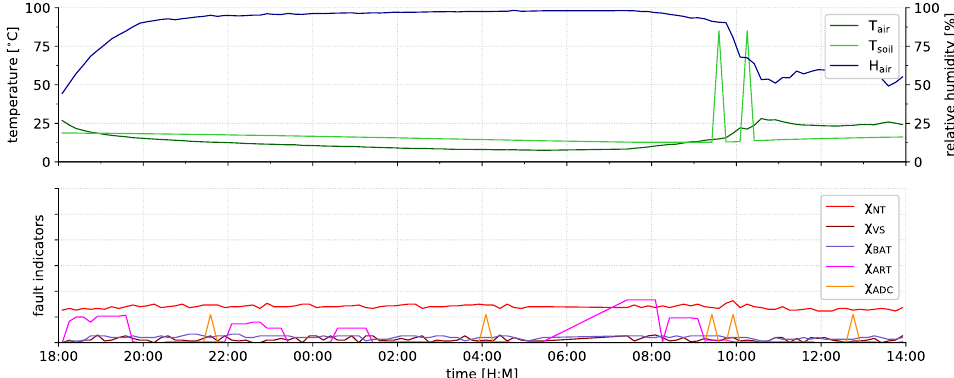
Figure 19. Example of a fault not highlighted by the fault